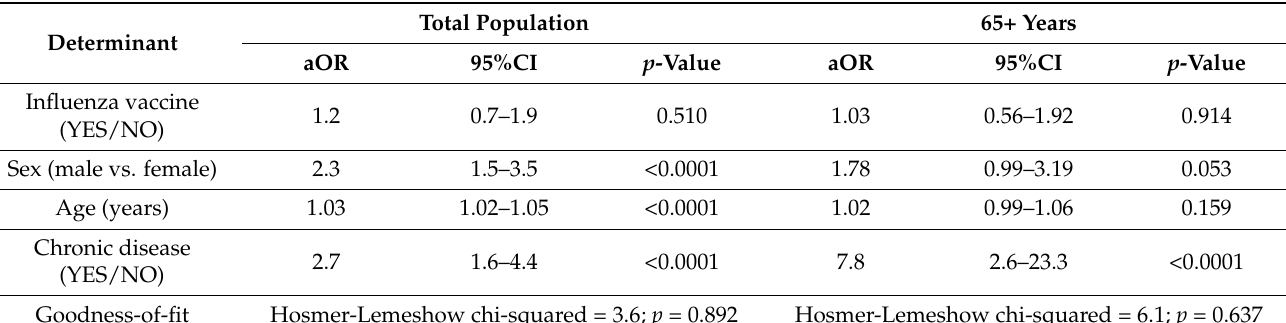
Table 1. The determinants of hospitalization according to multivariate logistic regression models for the total population and for patients 65+ years of age.